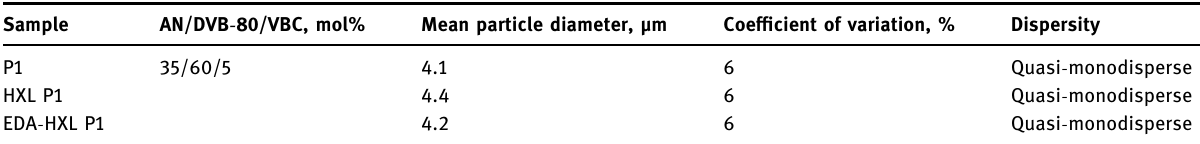
Table 2: The particle size of poly ( AN - co - DVB - 80 - co - VBC ) and hypercrosslinked poly ( AN - co - DVB - 80 - co - VBC ) terpolymers before and after the chemical modi fi cation